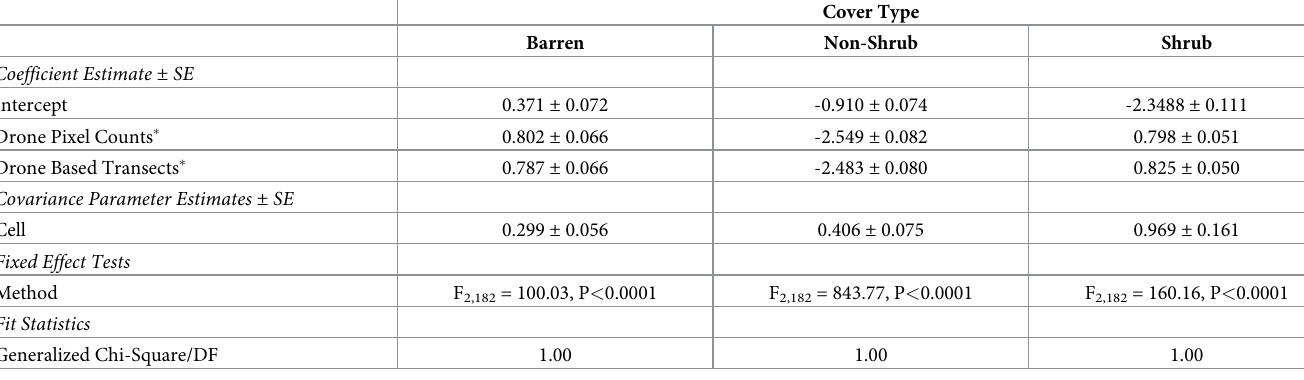
Table 4. Coefficient estimates from Beta GLMM for each cover type (barren, non-shrub, and shrub) as measured by ground based transects, drone based transects and drone pixel counts at 75 m AGL. Estimates obtained from 92 observations (cells) across 5 different study plots.